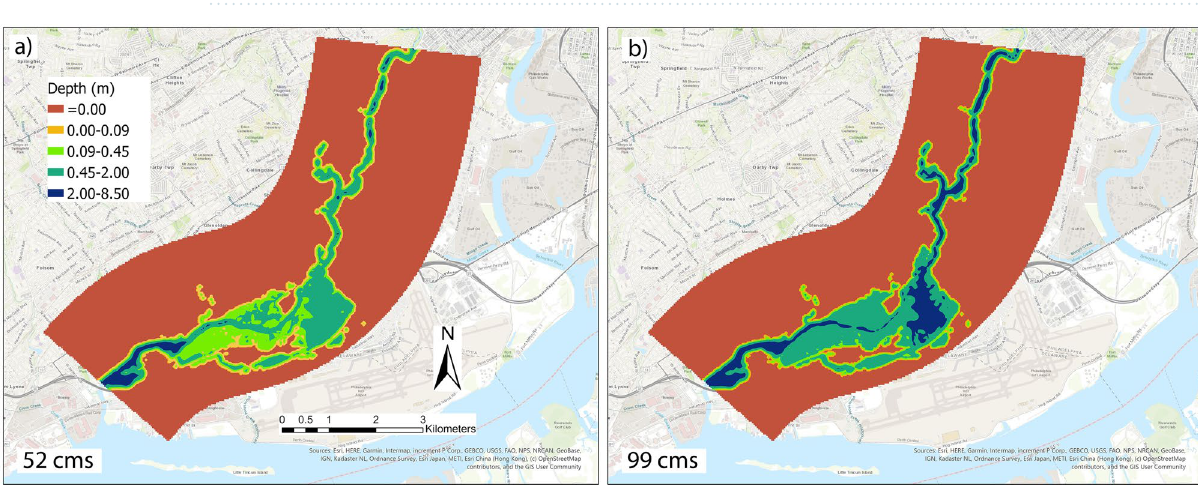
Figure 5. Blocked K-folds CV with a set of ten tarin/test splits.